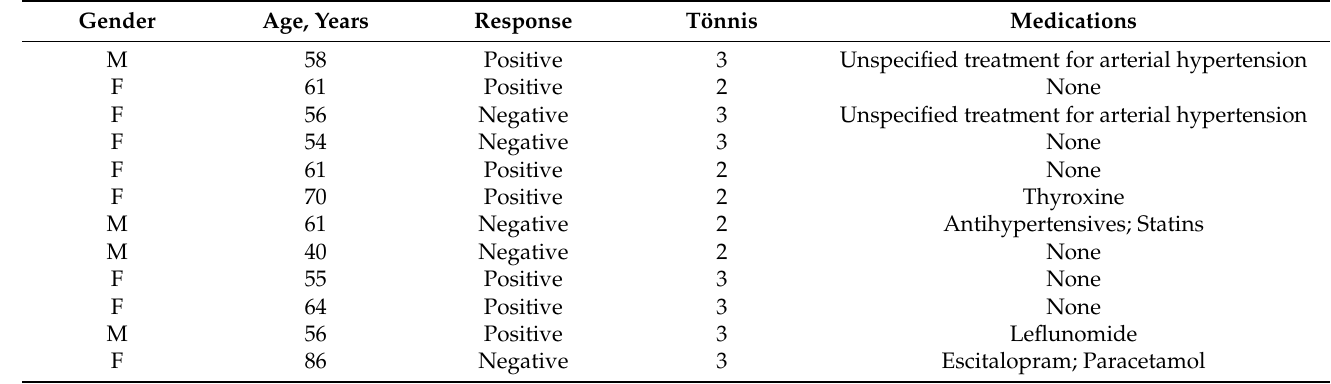
Table 1. The patient demographics and clinical assessment before and after